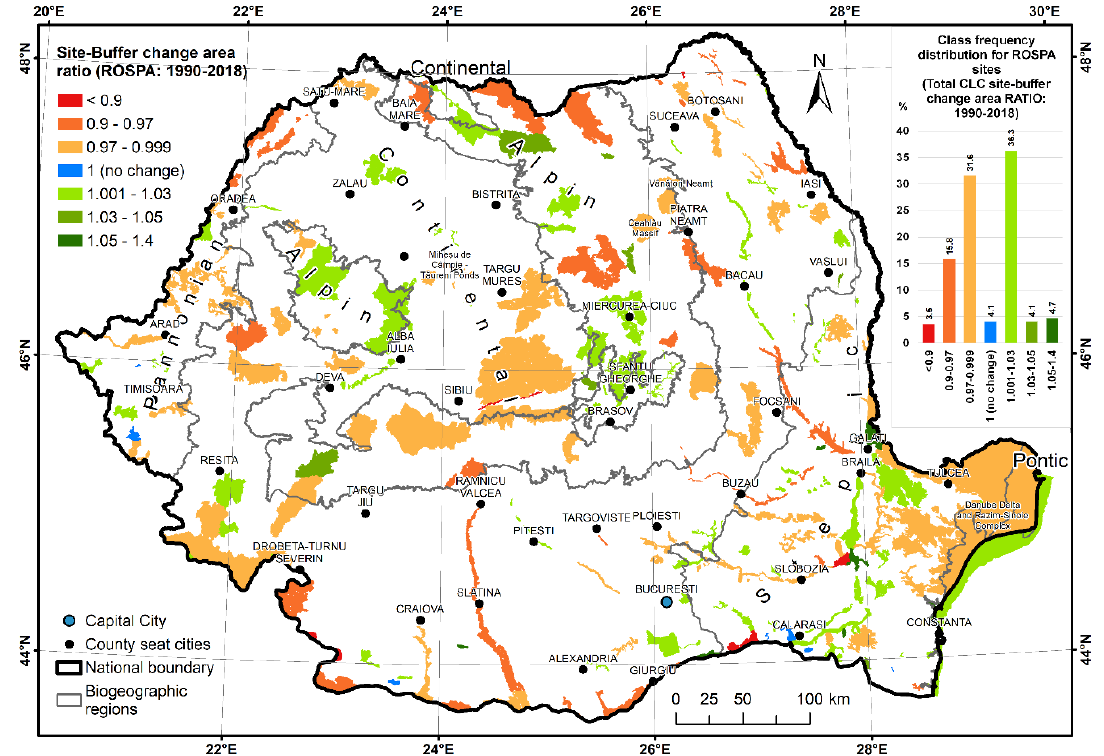
Figure 12. Change area in site vs. change area in buffer zones (ROSPA sites).